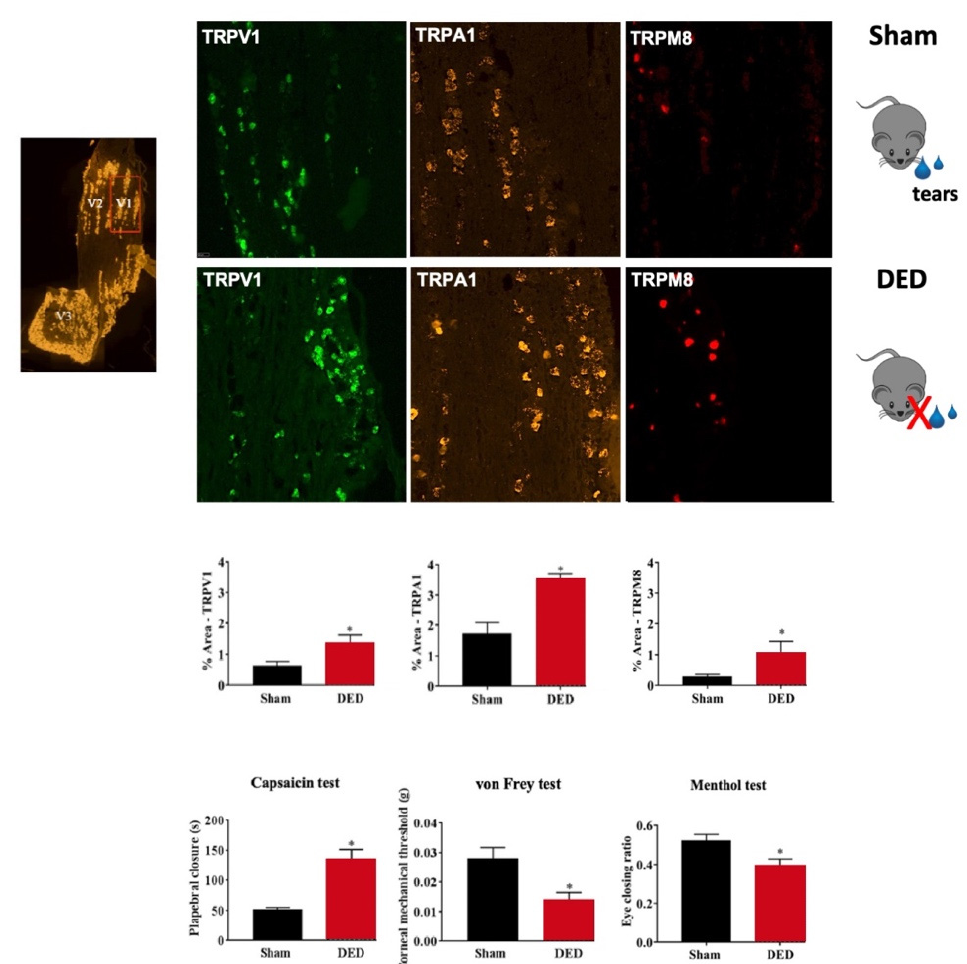
Figure 3. Evaluation of nociceptor expression in the ophthalmic branch of the trigeminal ganglion (TG) of sham and dry eye disease (DED) animals. Localization of the ophthalmic branch (V 1 , red rectangle), maxillary branch (V 2 ), and mandibular branch (V 3 ) in a mouse TG using the positive probe of RNAScope. Staining and quantification of mRNA levels by in situ hybridization of TRPV1, TRPA1, and TRPM8 in the ophthalmic branch of the TG of sham and DED animals. Evaluation of chemical and mechanical corneal sensitivity of sham and DED animals on d21. Chemical corneal sensitivity was evaluated by using a drop of capsaicin (100 µm) and recording the palpebral closure time for 5 min. The corneal mechanical threshold was measured using von Frey filaments. The cold corneal sensitivity was evaluated by using a drop of menthol (50 µm) and recording the eye closing ratio after 5 min. All experiments were conducted on d21 post lacrimal gland excisions. * p < 0.05 relative to the sham group. Results are expressed as the mean ± SEM. Images and bar charts adapted from [105].